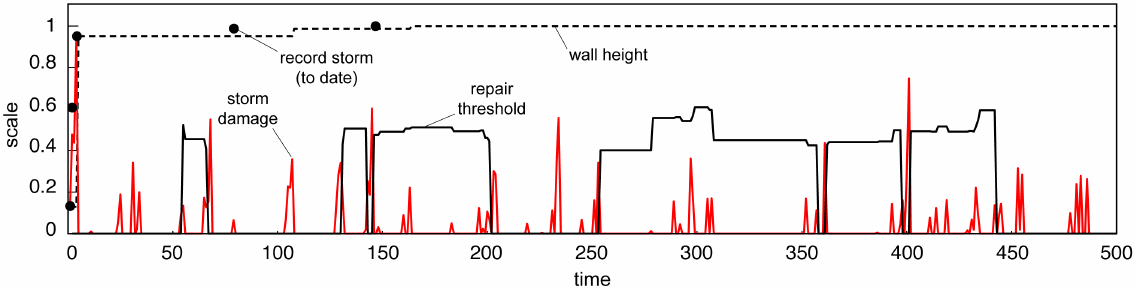
Figure 4. Representative time series of key model parameters (where D ∗ = 0.3, W ∗ = 0.4, and N = 10): record-setting storms (black dots), seawall height (dashed line), storm-driven damage (solid red line), and the threshold of cost e ff ectiveness for wall repair calculated by the manager agent (solid black line).